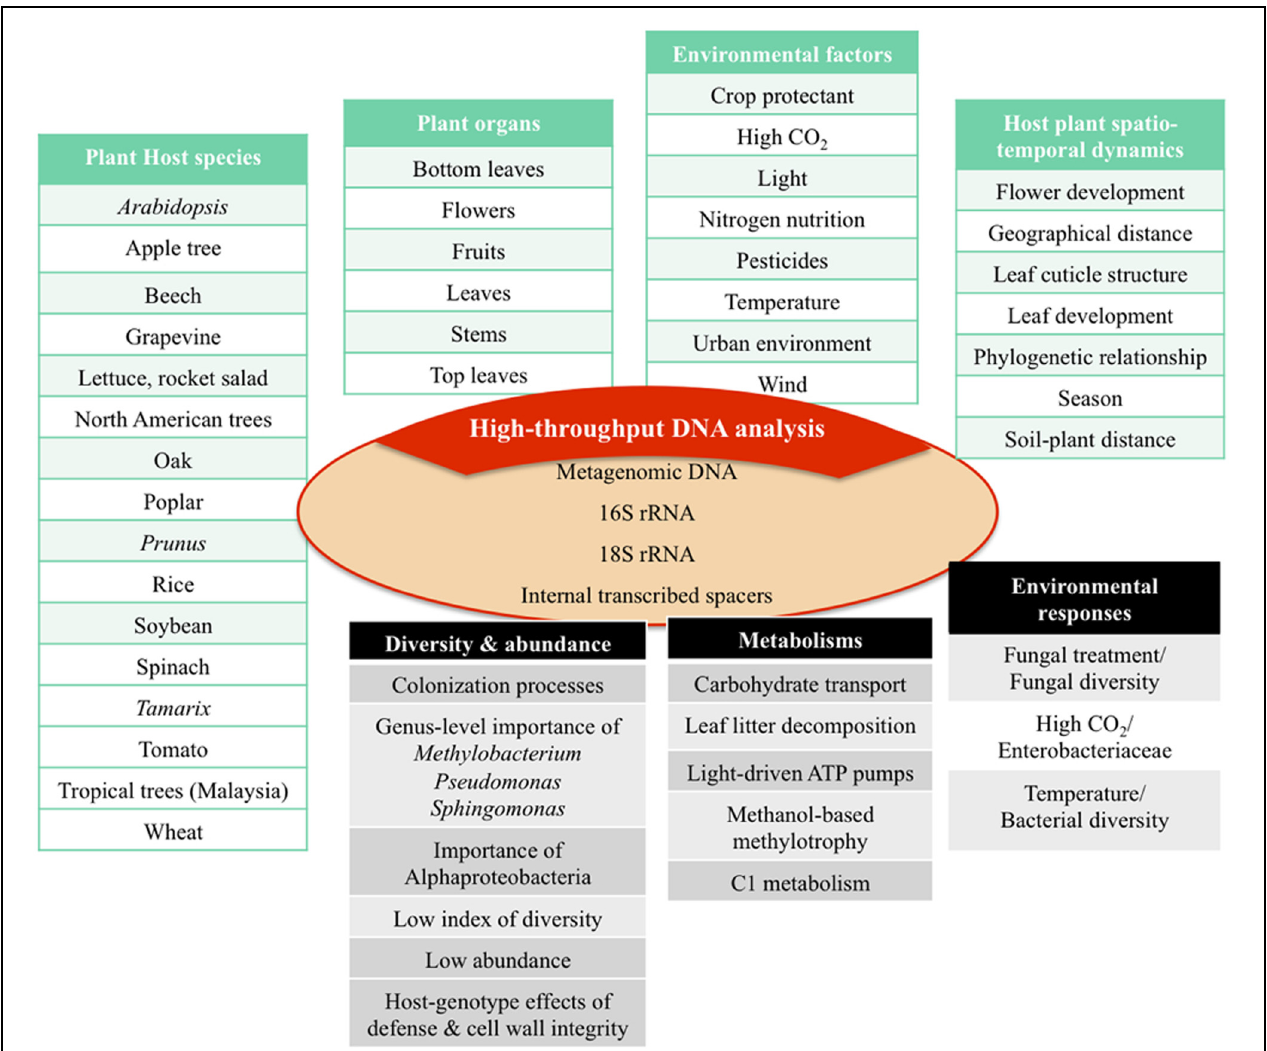
FIGURE 2 | High-throughput molecular analysis of microbial communities of the phyllosphere: from direct DNA sequencing to sequencing of prokaryotic and eukaryotic taxonomical markers. The present range of published studies covers a significant number of plant host species in various developmental and spatio-temporal contexts and under the influence of different environmental factors. The articles